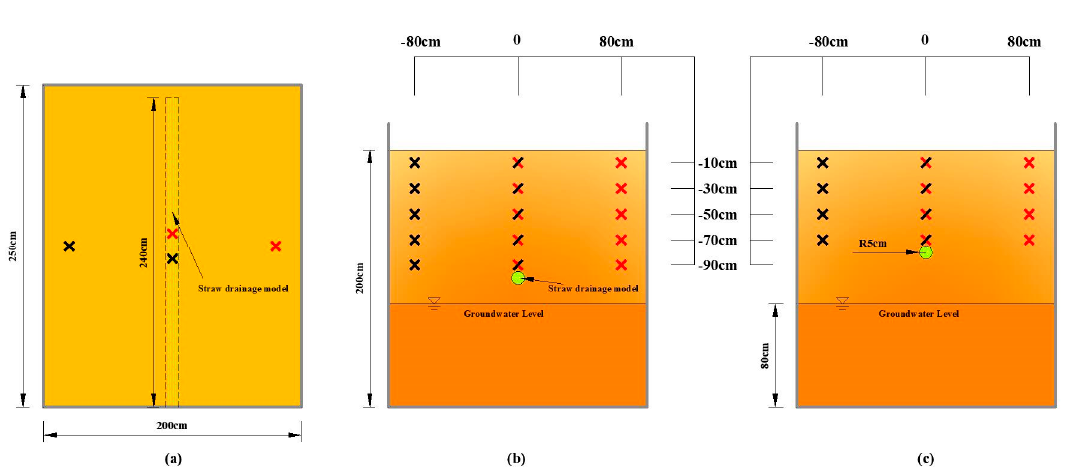
Figure 1. Locations of the sampling points in ( a ) horizontal plane view and in vertical plane views of ( b ) D1 treatment and ( c ) D2 treatment. Note: the cross in black, red, and black-red mean the soil sampling points were designed for water content, salt content, and both water content and salt content, respectively.